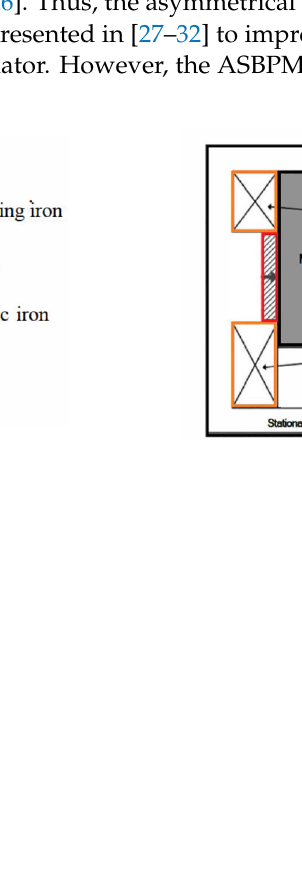
Figure 1. The structure of permanent magnet actuator. ( a ) Monostable permanent magnet actuator. ( b ) Bistable permanent magnet actuator. ( c ) Multi-magnetic circuit permanent magnet actuator.